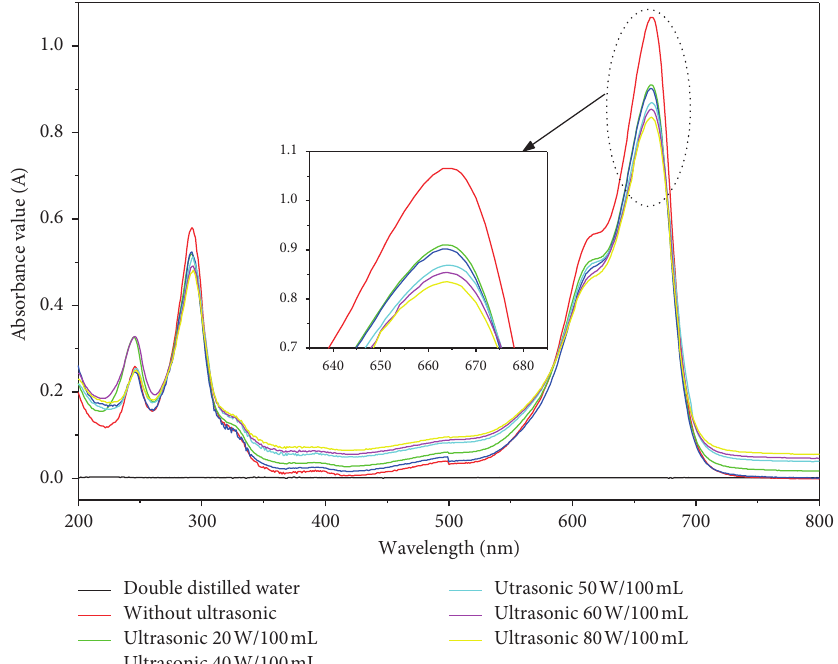
Figure 2: UV-visible spectra of methylene blue solution at different ultrasonic powers.